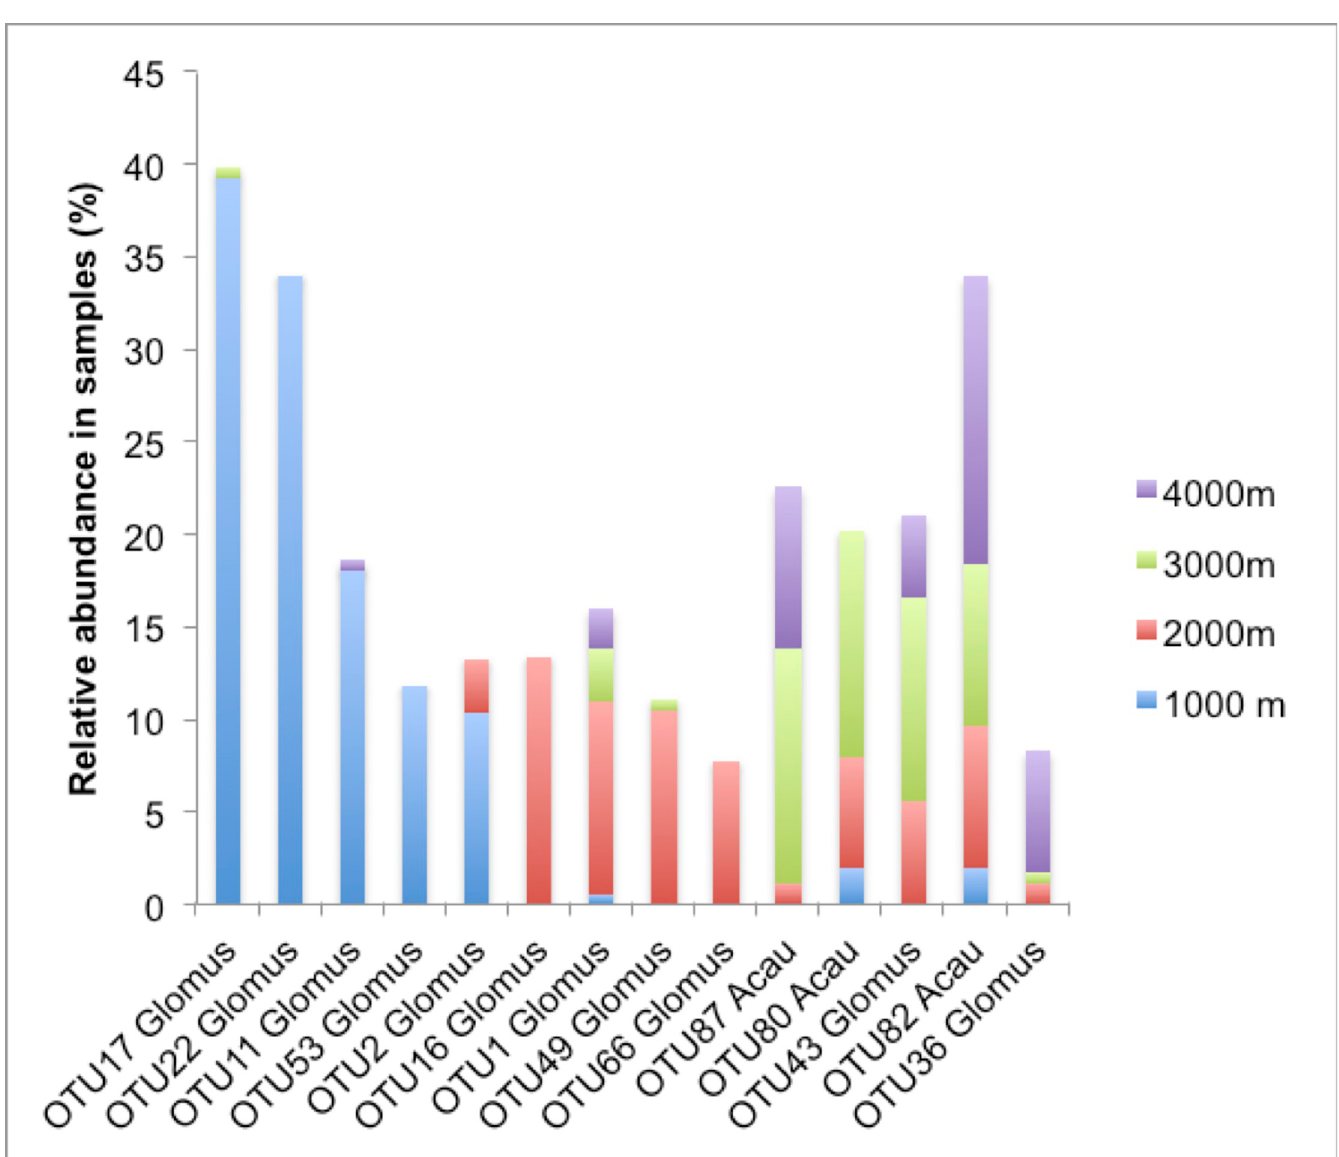
Fig 6. Relative abundance of most frequent OTUs ( > 10% of samples) for each elevation level. At the 1000 masl level, five Glomus OTUs were frequent with OTU17 and OTU22 occurring in over 30% of all samples. These OTUs showed low frequencies at other elevation levels. At 2000–4000 masl, the most abundant OTU was OTU16 ( Glomus ) at 2000 masl, and the most frequent OTUs at 3000 and 4000 masl were almost identical and also occurred at the other